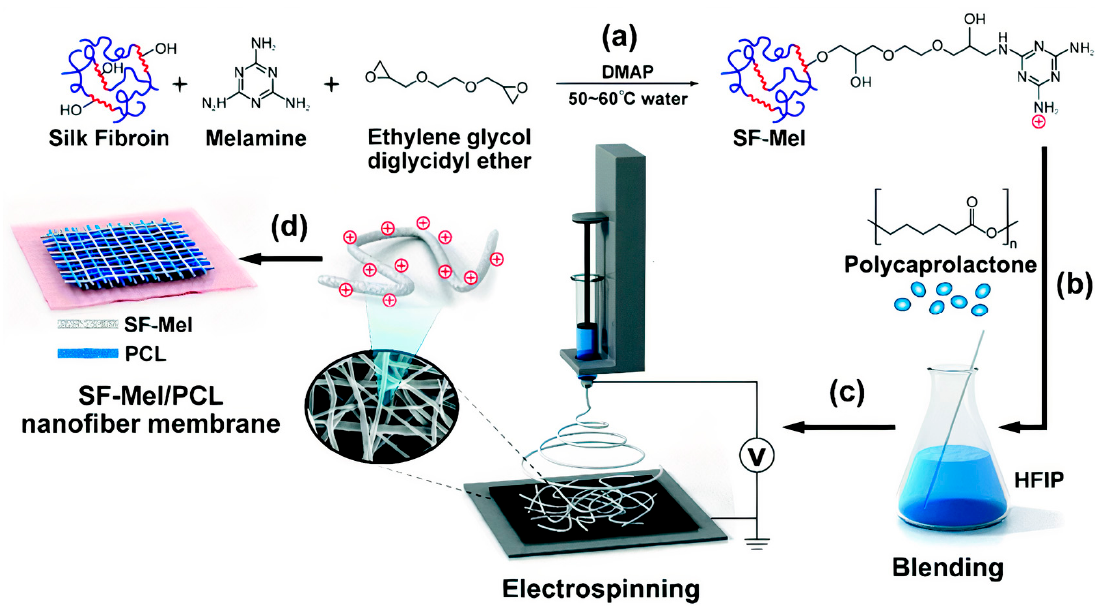
Figure 13. The film with cationic polymer useful as an antimicrobial wound dressing. ( a ) Melamine − modified silk fibroin (SF–Mel) was synthesized by covalent conjugation between silk fibroin and melamine. ( b ) Polycaprolactone (PCL) blended with SF–Mel enhanced the mechanical properties. ( c ) SF–Mel/PCL nanofiber films were fabricated via electrospinning. ( d ) Nanofiber membrane comprising SF–Mel/PCL was constructed as a wound dressing for skin repair. Adapted with permission from [180]. Copyright 2019 The Royal Society of Chemistry.